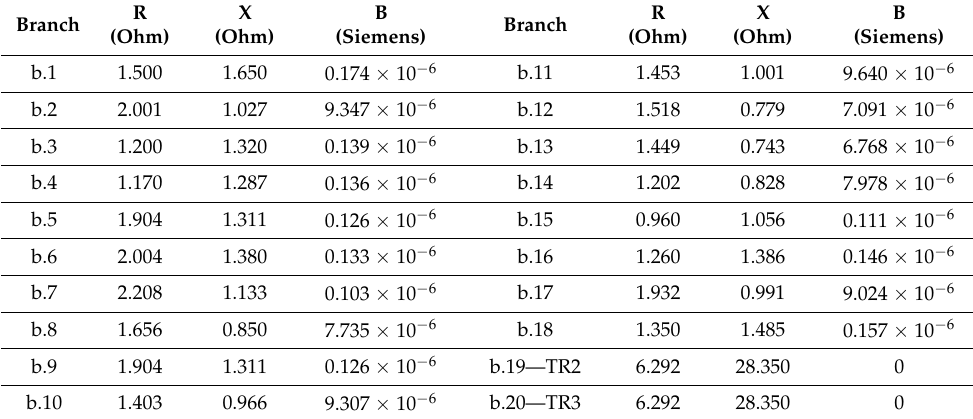
Figure 7. Simulated network diagram. Table 2. Branch parameters.